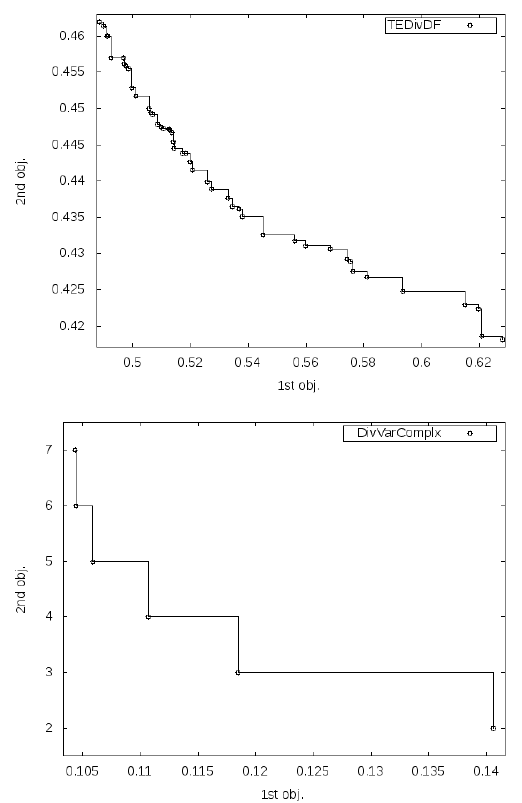
Fig. 4. The Pareto front approximation obtained for abalone using fitness function 2c (objective 1 stands for training er- ror and objective 2 for double fault) on the top, and fitness function 2d (Objective 1 stands for variance and objective 2 for complexity) on the bottom.